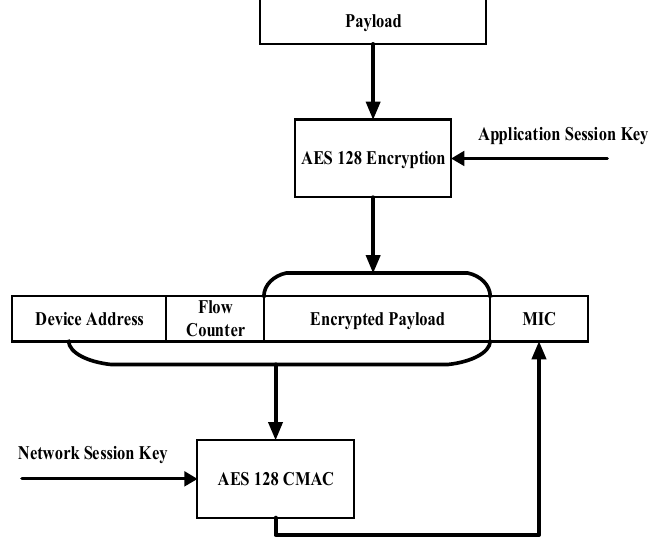
Figure 3. Encryption and message signing in LoRaWAN.